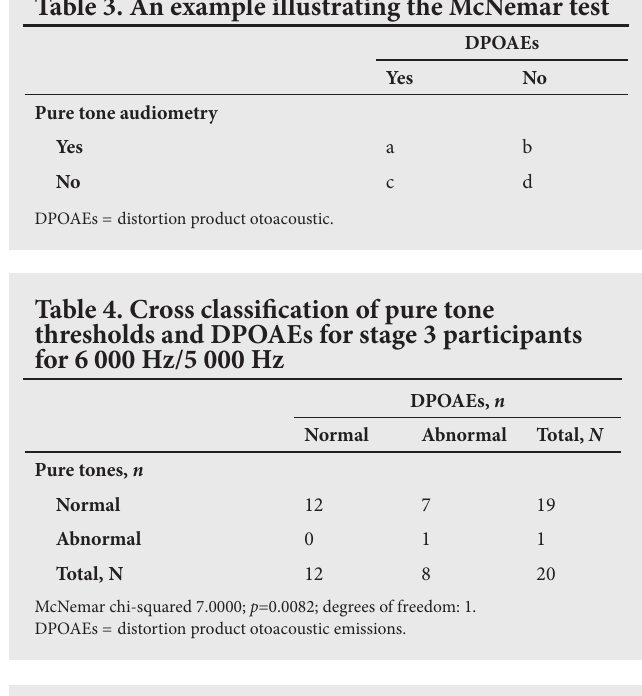
Table 5. Cross classification of pure tone thresholds and DPOAEs for stage four participants